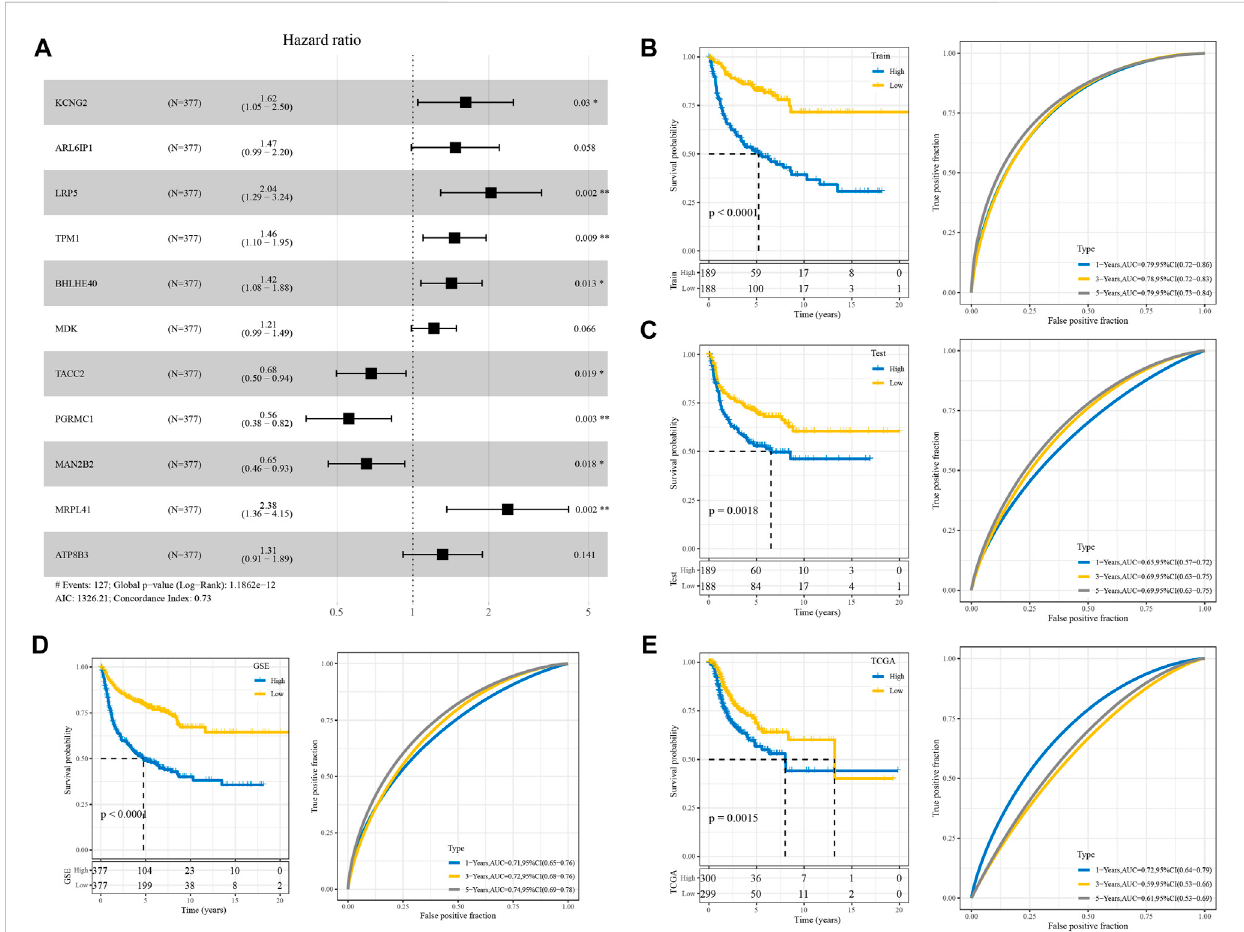
FIGURE 4 ValidationoftheRiskScoremodel. (A) ForestdiagramofmultivariateCoxanalysisofthemodelgenes. (B) ROCandKMcurvesofRiskScoreusingGSE training data. (C) Verifying ROC curve and KM curve of RiskScore in “ my data queue ” in GSE. (D) ROC and KM curves of RiskScore in the GSE cohort. (E) ROC and KM curves of RiskScore in TCGA